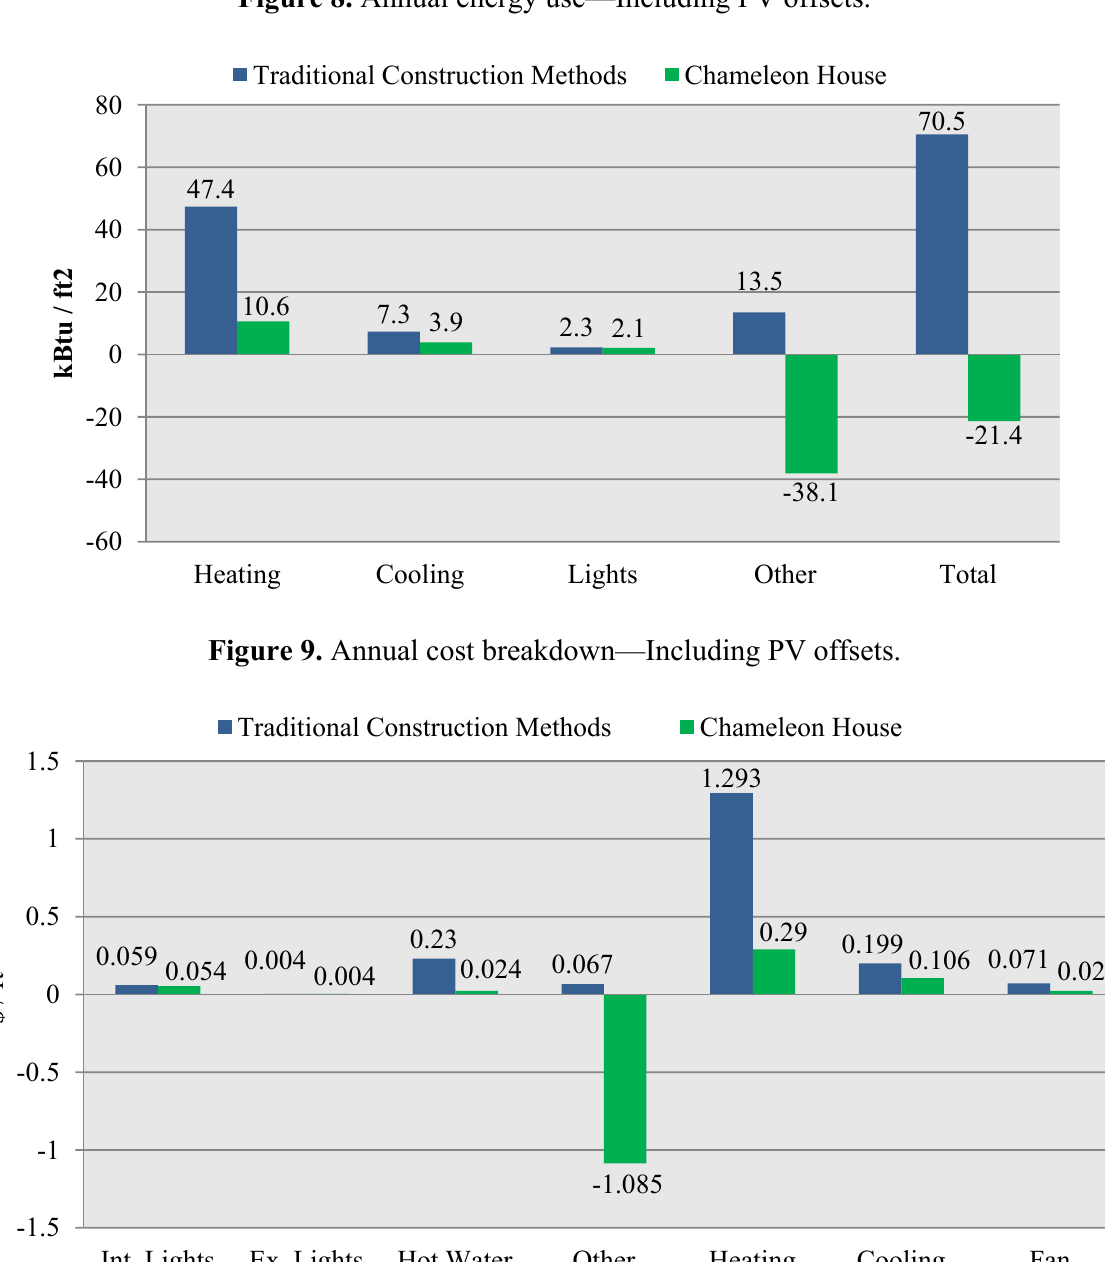
Figure 8. Annual energy use—Including PV offsets.